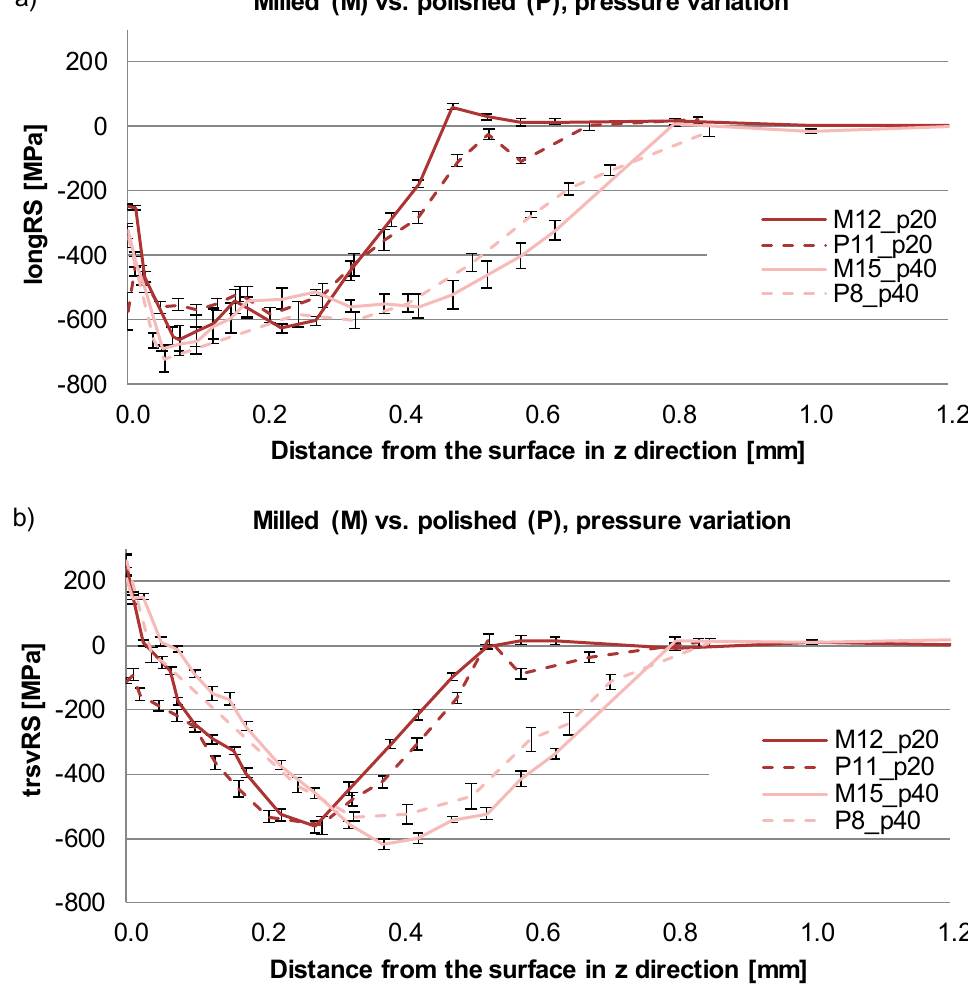
Figure 8. Residual stress depth distribution (measured with Seifert) after DR by different pre-machining states, i.e., milled and DR (designation “M”) or milled, polished and DR (designation “P”) and different DR pressure (designation “p”); ( a ) longitudinal residual stresses (longRS) and ( b ) transverse residual stresses (trsvRS).